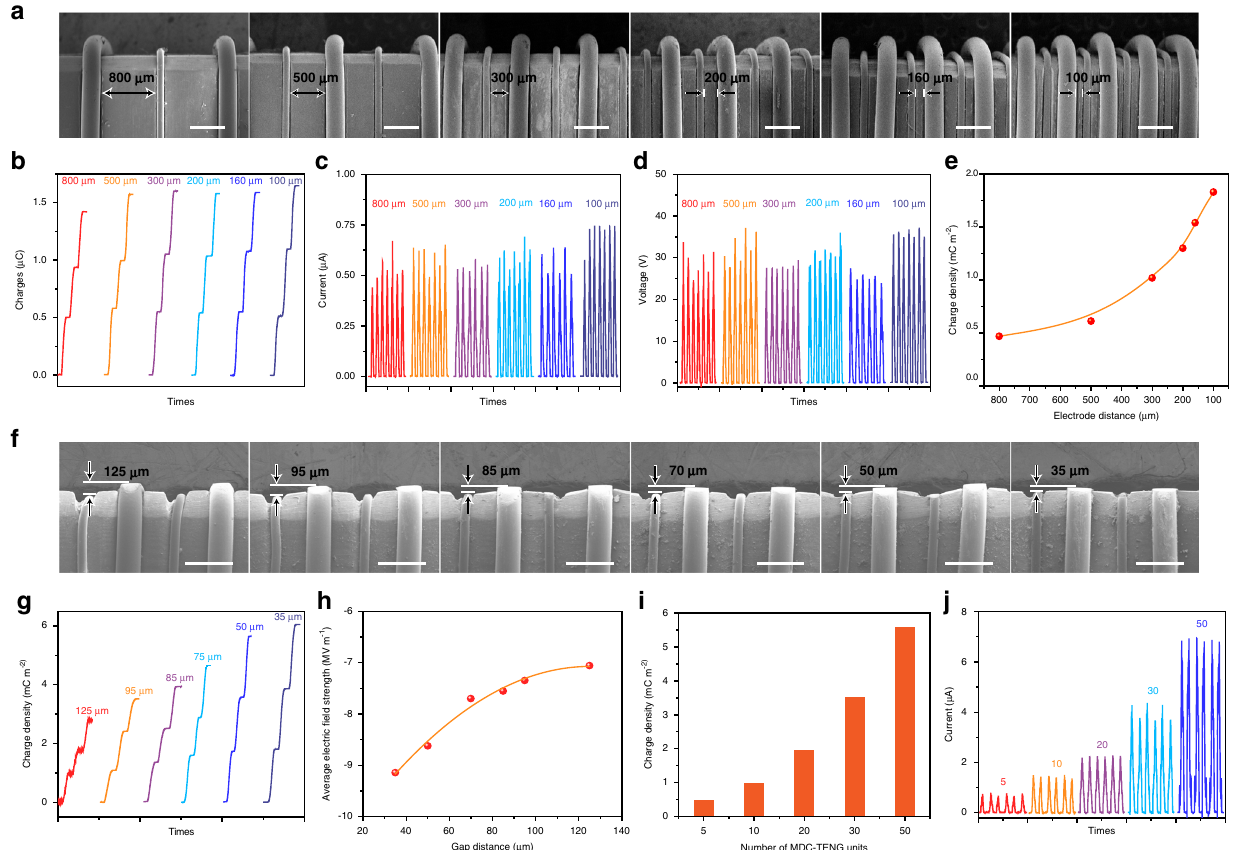
Fig. 4 Structural optimization and output performance of MDC-TENG. a The SEM images (scale bar: 500 μ m) and corresponded b charge density, c I sc , and d V oc of MDC-TENG with different electrode distance (number of MDC-TENG units: 5). e Charge density calculated by the friction area and MDC-TENG device area. f The SEM images (scale bar: 500 μ m) and g corresponded charge density of MDC-TENG with different gap distance. h The average electric fi eld in the gap between CCE and PTFE surface (simulated by COMSOL software). i Charge density and j I sc of MDC-TENG with various MDC-TENG units. Test parameters: sliding distance: 10 cm, friction layer: